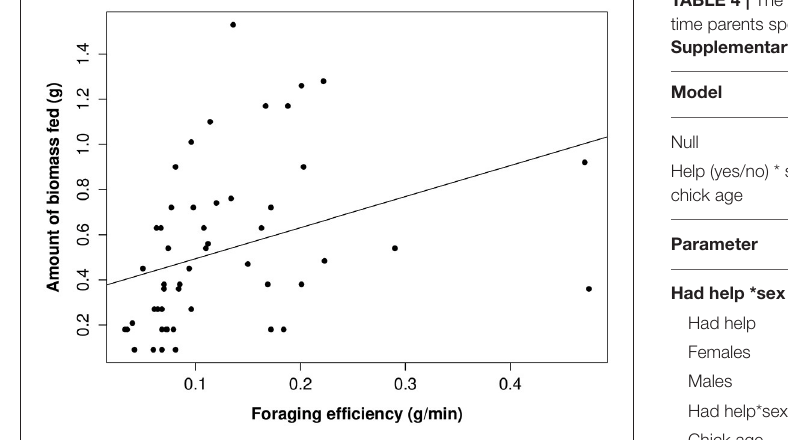
FIGURE 4 | The relationship between the amount of biomass fed to young per 20min focal by adults and helpers and foraging efficiency. Raw data values are displayed against the line of best fit generated from the top model presented in Table 3 .